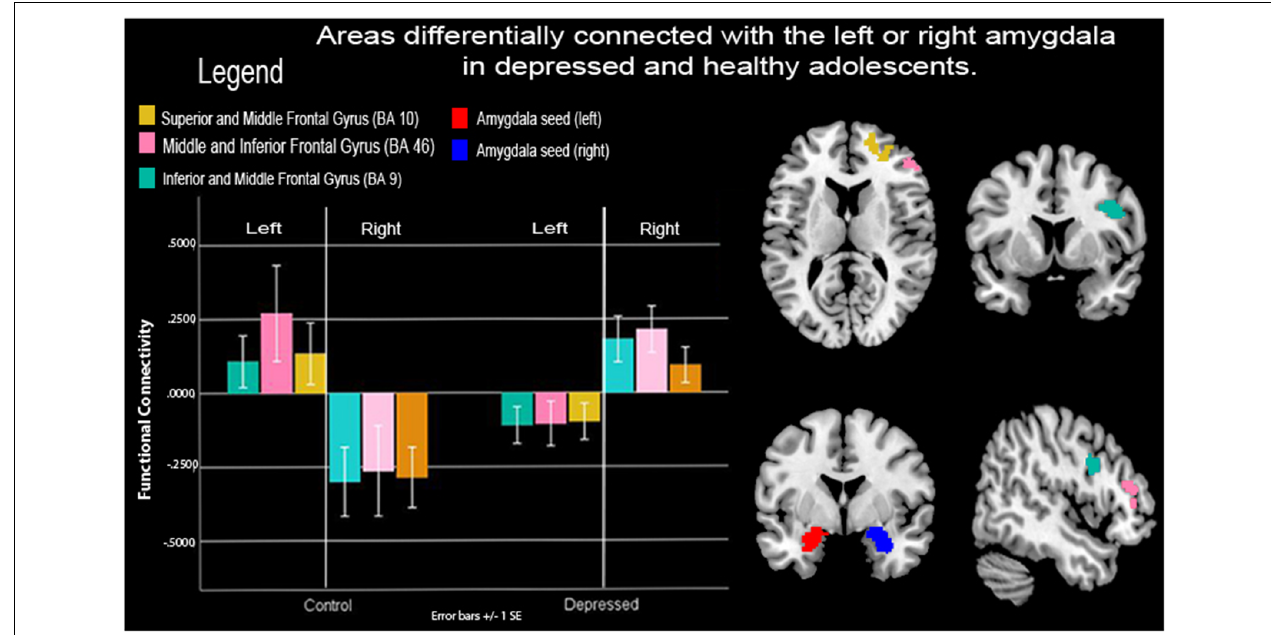
FIGURE 2 | Functional connectivity (FC) between amygdalae and right prefrontal cortex (PFC) during neurofeedback in depressed and healthy adolescents. Depressed adolescents exhibited lower-left vs. right amygdala connectivity to right frontocortical areas during a neurofeedback condition that prompted the recall of positive autobiographical memories cued to a happy-self face image vs. a control condition that prompted counting backward cued to a happy unfamiliar face. Healthy control adolescents showed the opposite pattern. Note: SE, Standard error of the mean.